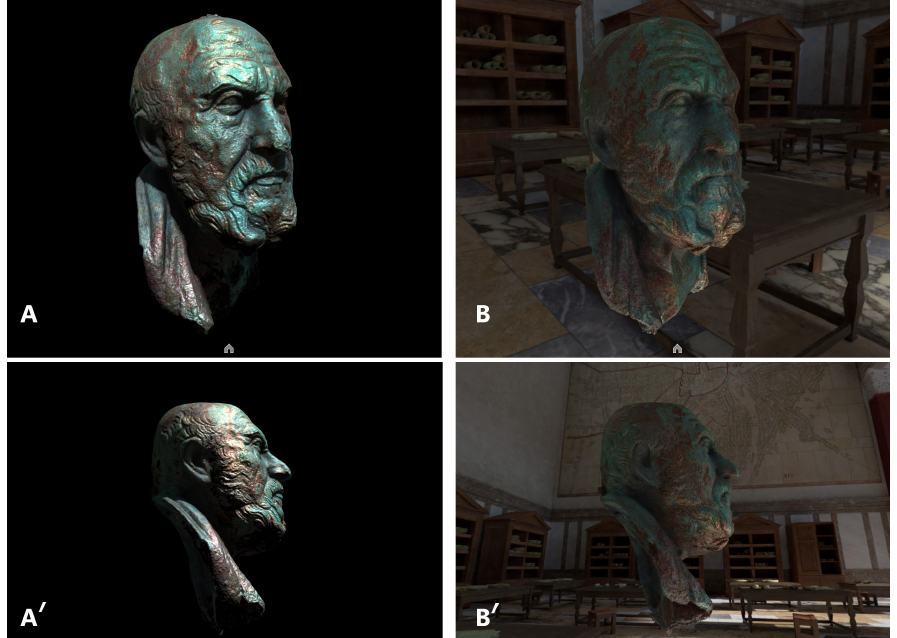
Figure 18. Interactive visualization in ATON of the same item using two different environments and lighting setups: modern lighting ( A , A’ ) and original context ( B , B’